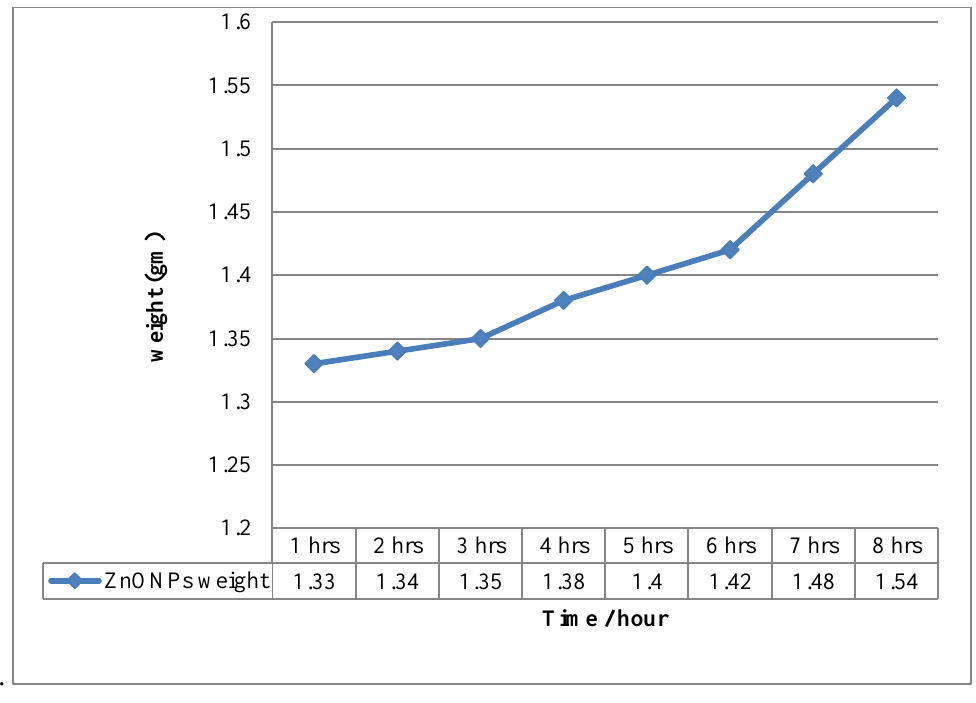
Figure 2. Weight of ZnONPs synthesized by PPE